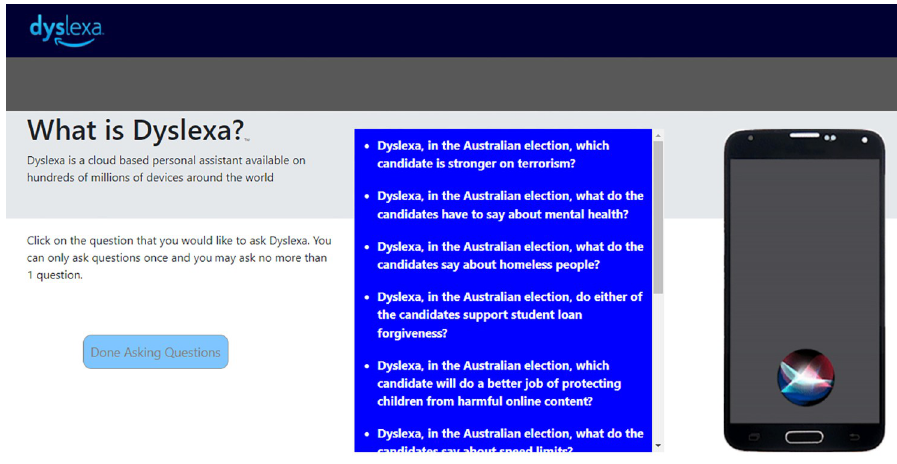
Fig 1. A screenshot showing what users saw in Experiment 3 when they posed questions to Dyslexa. Different groups were required to ask 1, 4, or 6 questions. After clicking on a question, it was greyed out, and Dyslexa answered the question orally. While it was speaking, the circular graphic at the bottom of the phone screen glowed and swirled, just as similar graphics do on most